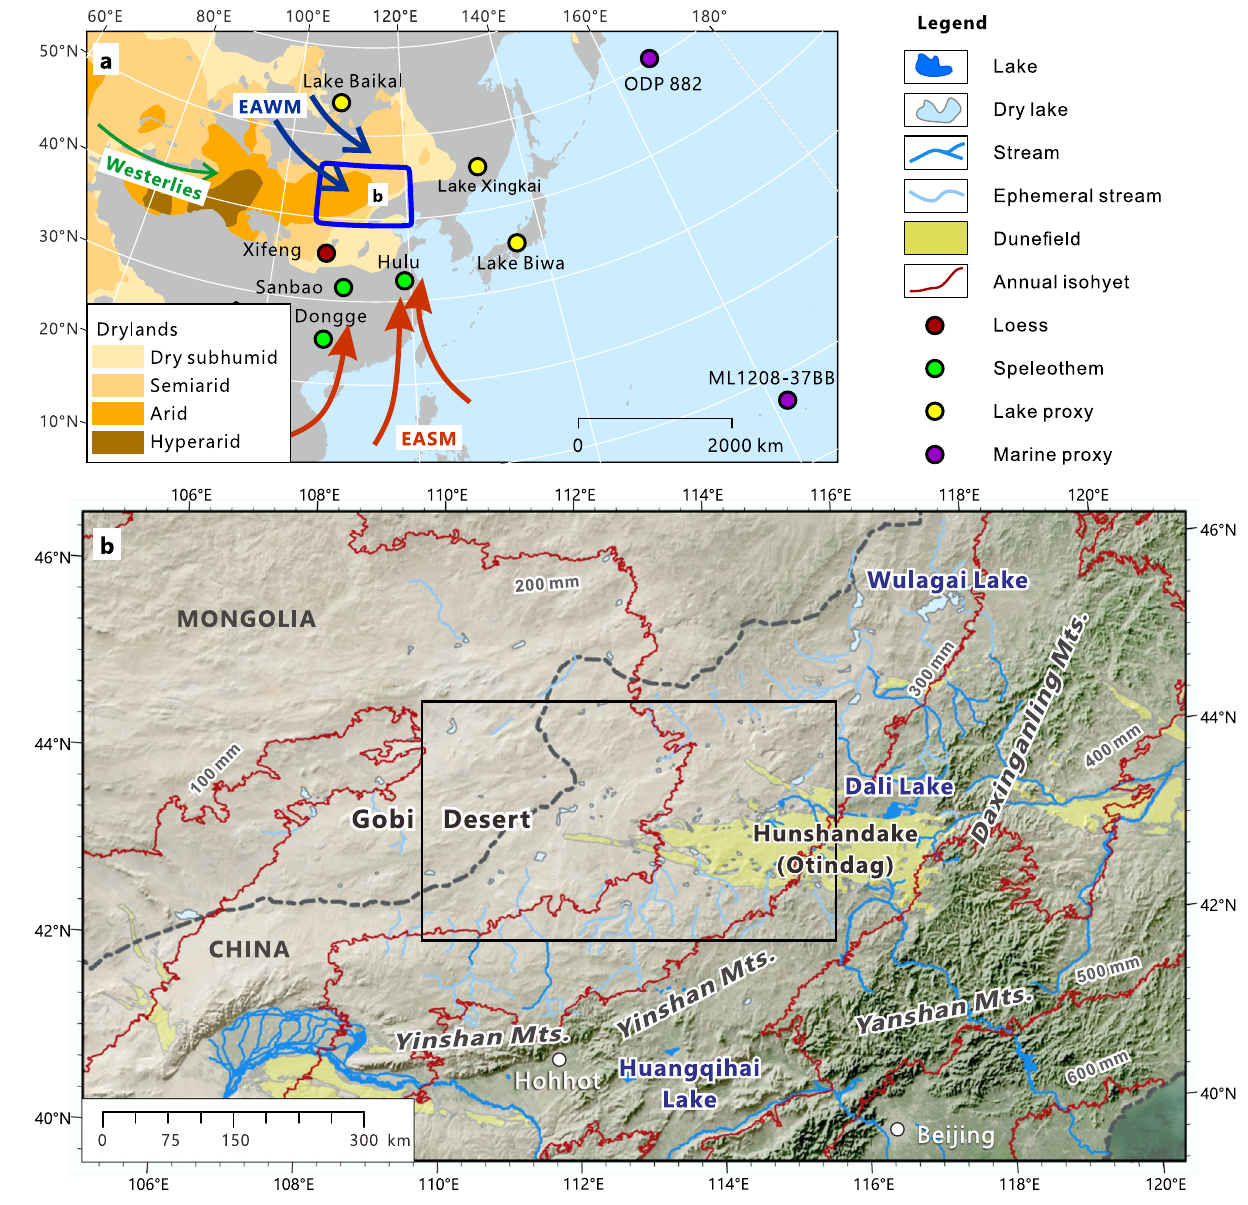
Fig. 1 | Hydroclimatic context of the East Gobi Desert. a Map of the East Gobi Desert showing its location within the northern mid-latitude dryland system. Pre- vailing winds of the East Asian Winter Monsoon (EAWM), East Asian Summer Monsoon (EASM), and the Westerlies are also indicated. Circles with different